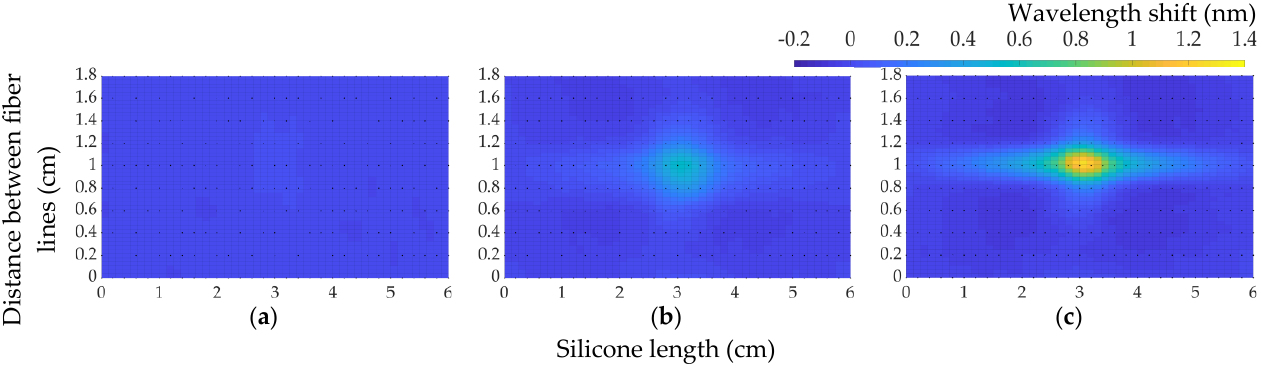
Figure 9. 2D map of wavelength shift distribution on 50 g ( a ), 550 g ( b ), and 900 g ( c ).